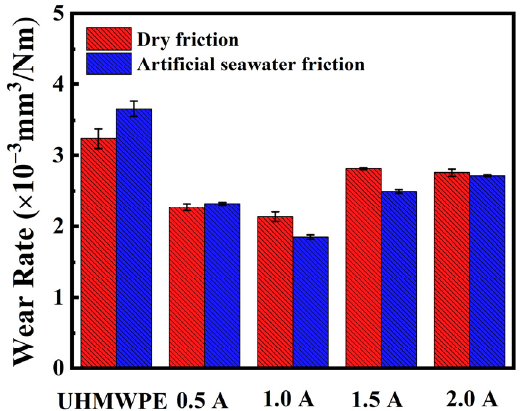
Figure 14. The wear rate of UHMWPE substrates treated with different carbon plasma currents under two environments.